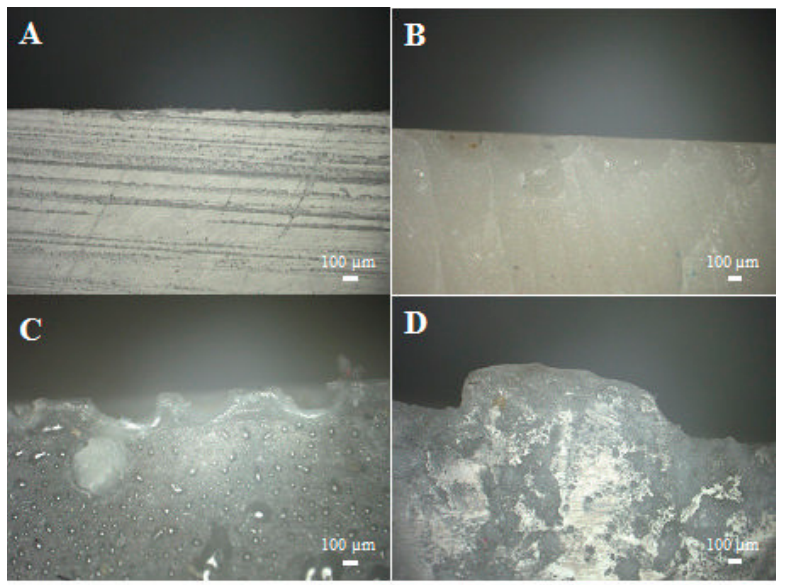
Figure 9. Photos of side edges of the samples, ( A )—glass, degassed; ( B )—glass, non-degassed; ( C )—silicone, degassed; ( D )—silicone, non-degassed.